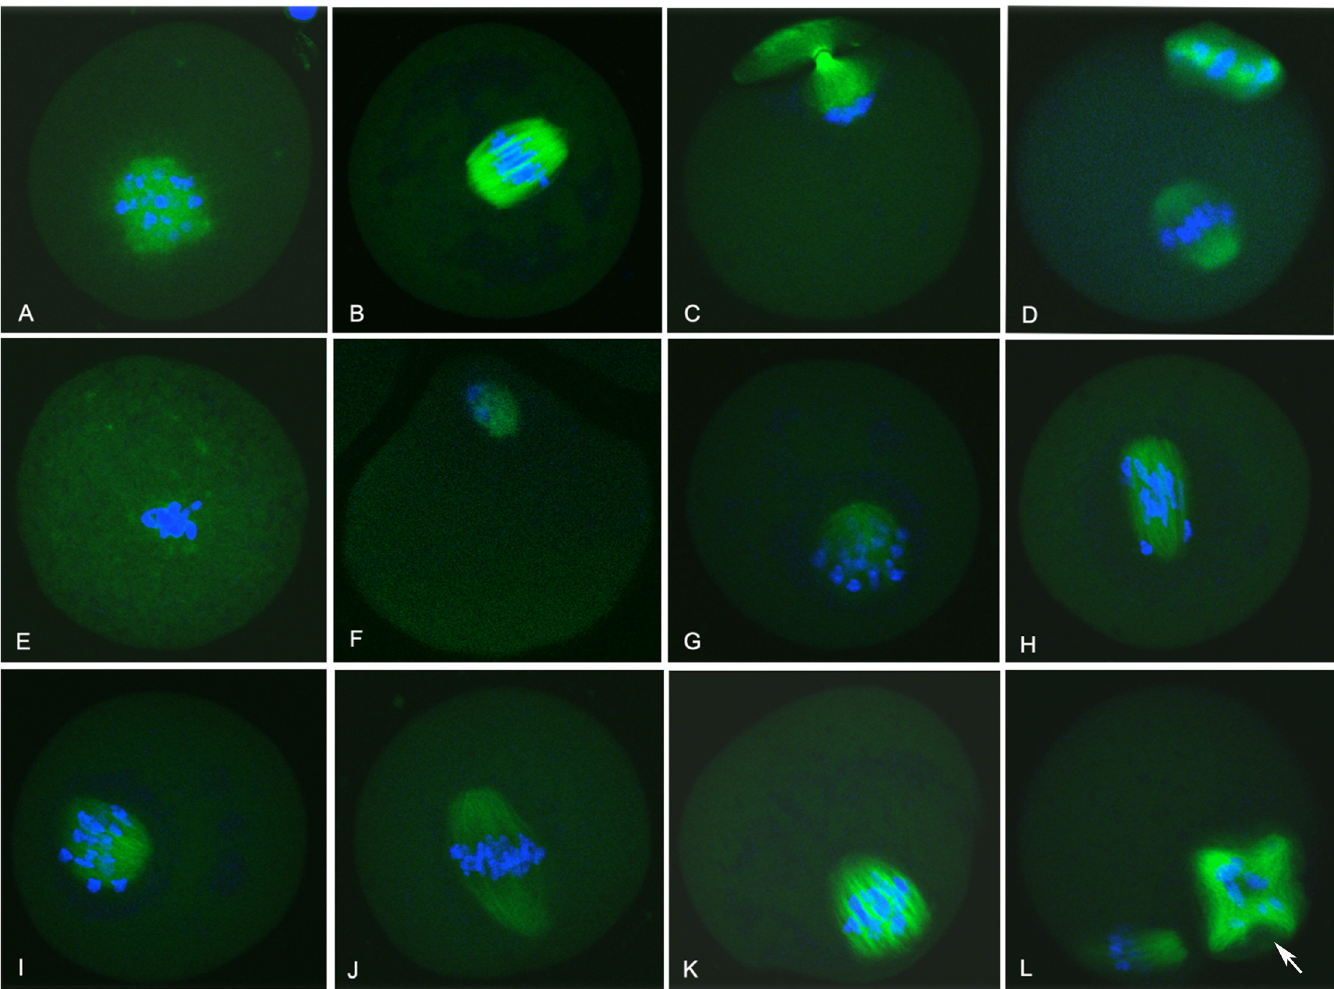
Fig 4. Antibody-mediated inhibition of the binding of RGS2 and β -tubulin in GV oocytes leads to spindle defects during maturation. All stages of control rabbit IgG-injected oocytes were cultured for 1 h (A), 4 h (B), 6 h (C), or 9 h (D) after GVBD, and all oocytes showed normal morphologies. Anti-Rgs2 antibody-injected oocytes were inhibited and exhibited various spindle morphologies (Fig 4E – 4L), including microtubule accumulation near the chromatin condensing region, but almost no β -tubulin polymerization in the spindle (Fig 4E). Although a few oocytes were assembled into a normal MI spindle (Fig 4J), most oocytes were blocked at the metaphase I to anaphase I stage (Fig 4F – 4K) and were accompanied by spindle defects, such as non-integral spindles (Fig 4G, 4I and 4K) and chromosomal migration failure (Fig 4F, 4H and 4J). Some MII oocytes even extruded first polar bodies that remained morphological abnormal in spindle (Fig 4L, arrow points to a muti-polar spindle). Images show staining of nuclei in blue and RGS2 in green. Scale bar, 20 μ